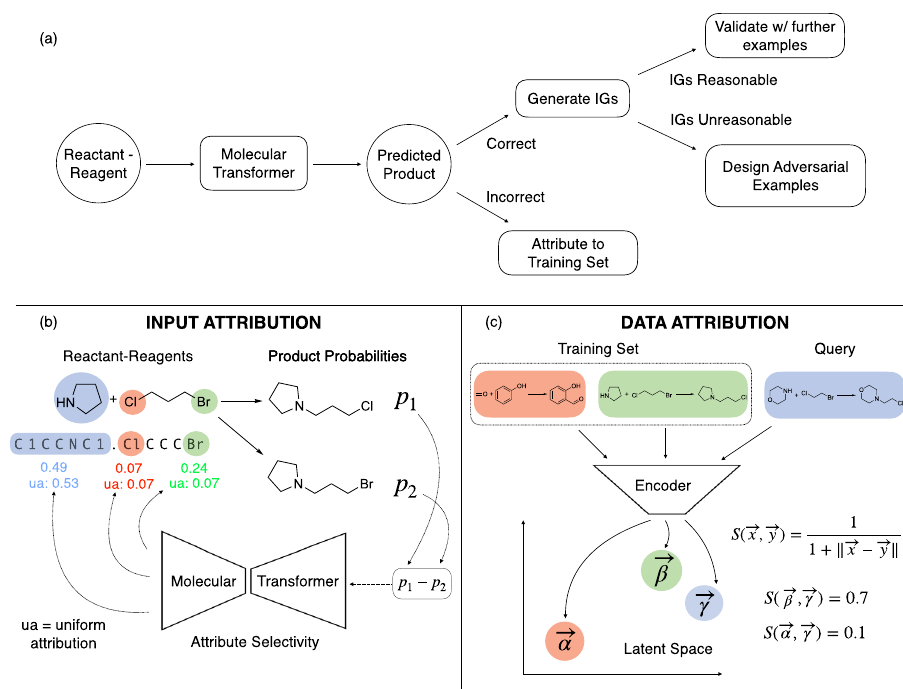
Fig. 1 Schematic illustration of the attribution work fl ow. a Overview of our work fl ow to interpret the Molecular Transformer. b Schematic of how the predicted probability difference between two products are attributed back to the reactant-reagent string in order to interpret the model ’ s understanding of selectivity. The IG attributions below the reactant SMILES are compared to the uniformly distributed probability difference (ua) below. c Schematic of how the latent space encoding of reactant-reagent strings are used to infer the learnt similarity between query reactants and those from the training set.